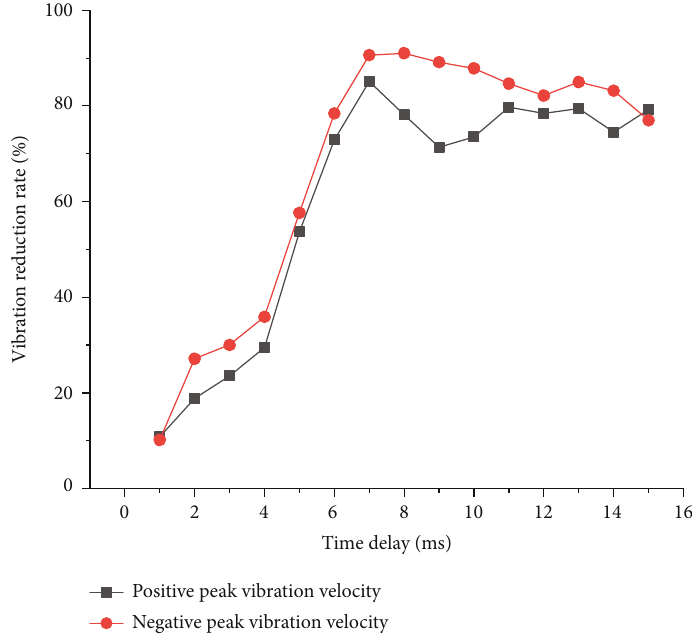
Figure 10: Variation of vibration reduction rate with time delay. Table 3: Statistics of peak vibration velocity of the cut